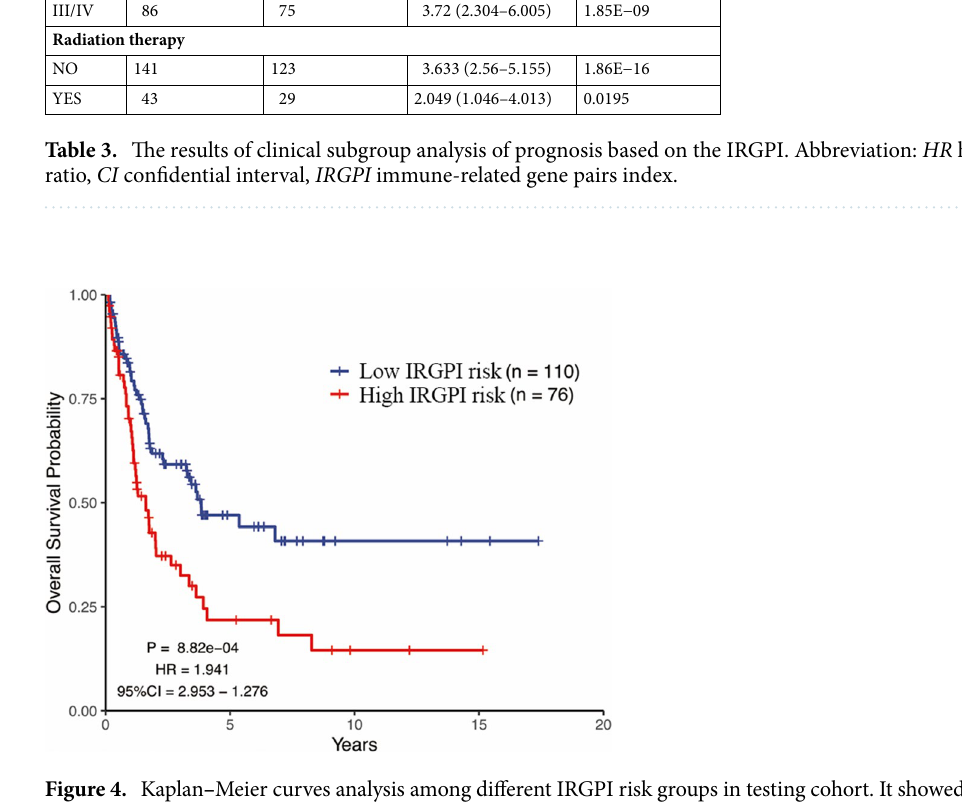
Figure 4. Kaplan – Meier curves analysis among different IRGPI risk groups in testing cohort. It showed that the impact of IRGPI on overall survival in testing